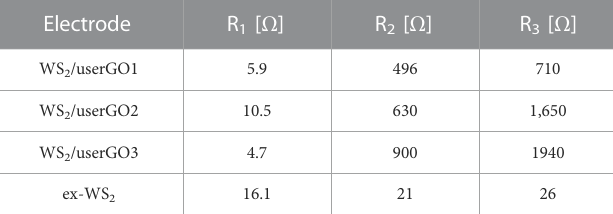
TABLE 2 Fitted results of the equivalent circuit models in Figure